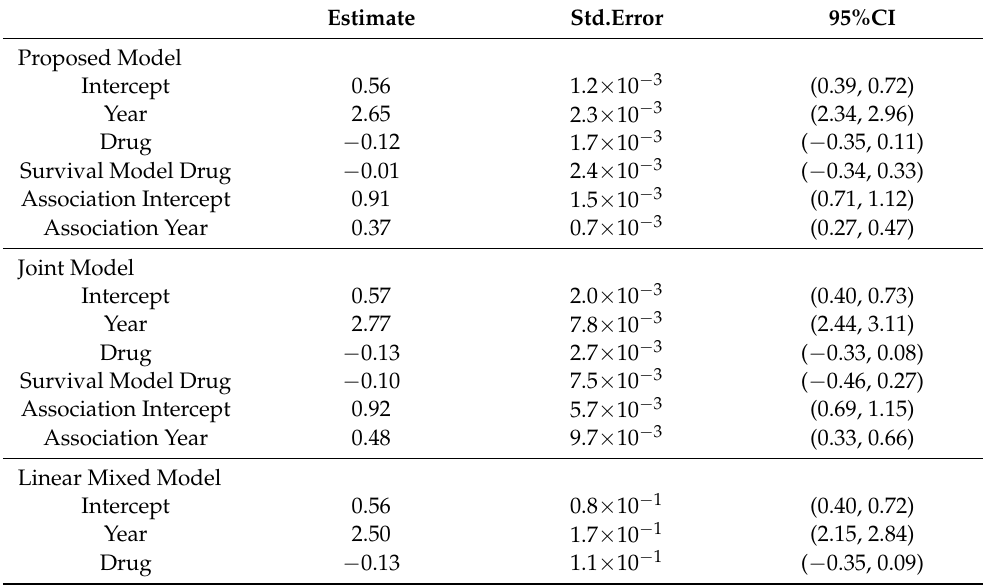
Table 2. Results from the pbc2 data with the proposed model, the existing JMbayes package, and the linear mixed model. Estimate